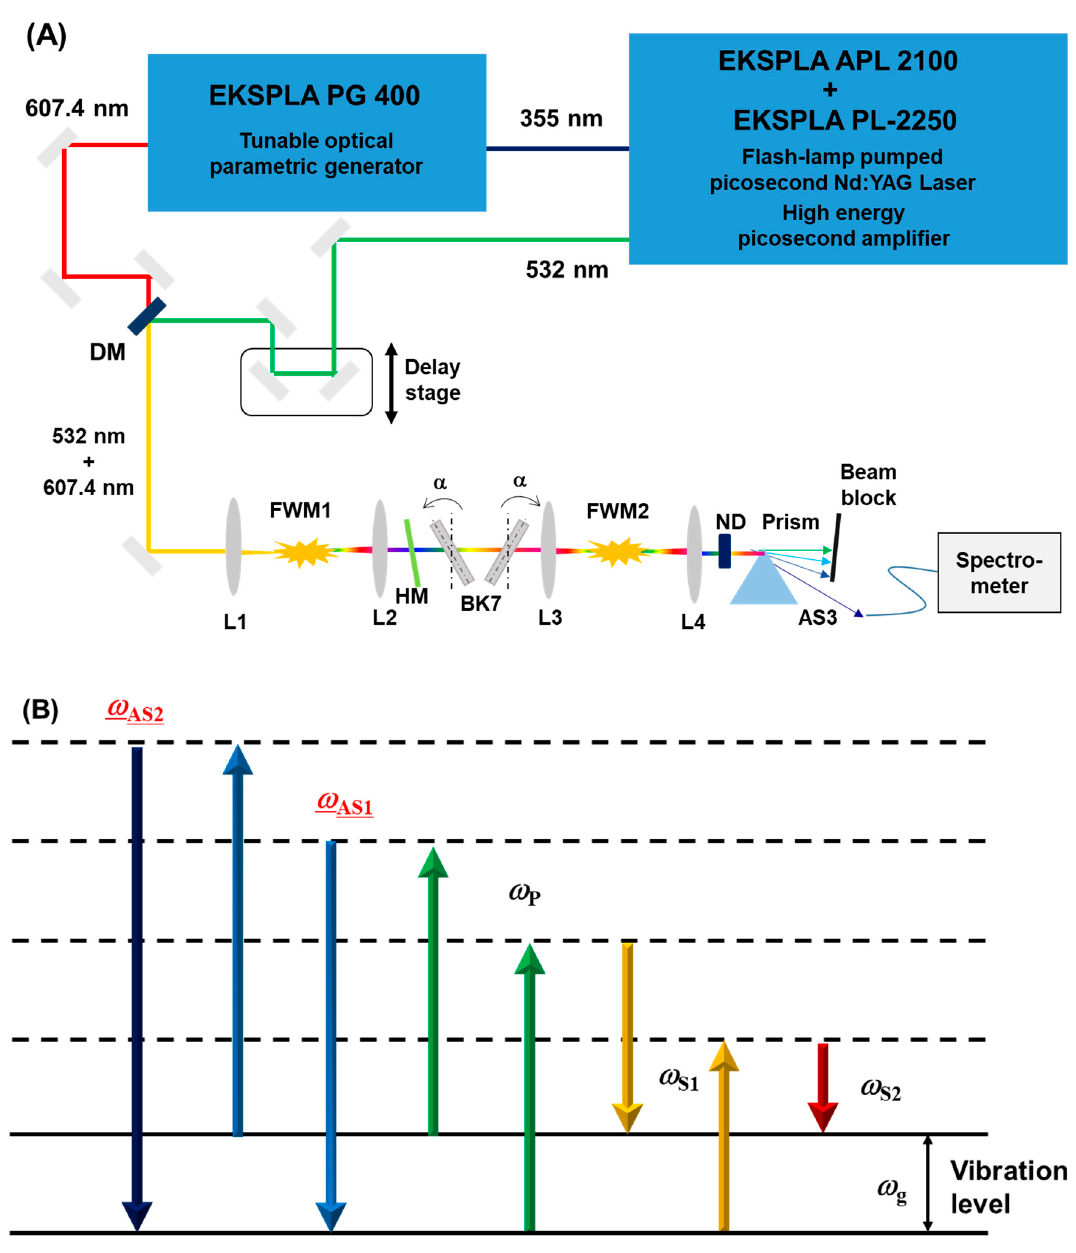
Figure 1. ( A ) Experimental setup for generating multiple Raman sidebands in air. DM: Dichroic mirror, L1–4: Convex lenses, HM: 532 nm high reflection mirror, BK7: 12 mm thick BK7 plates, ND: Neutral density filters, FWM1,2: The interaction points. ( B ) Energy level diagram for the cascaded Raman sideband generation, ω (AS1-2) : anti-Stokes, ω p : pump, ω (S1-2) : Stokes sidebands. Dashed lines show virtual energy levels.